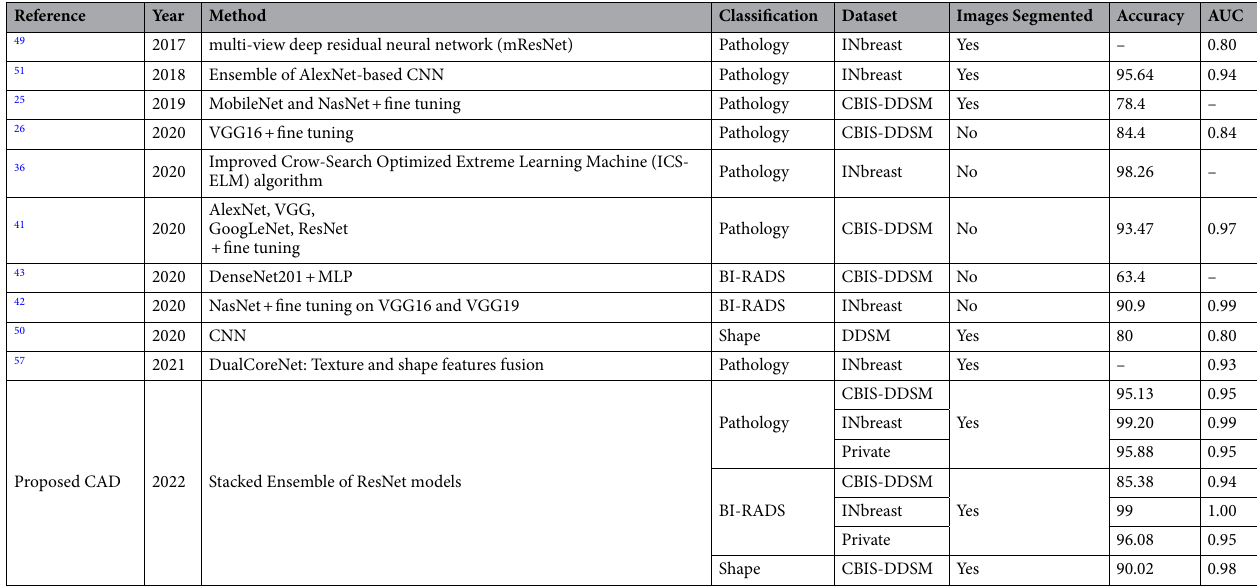
Table 14. Comparison of the proposed methodology and state-of-the-art